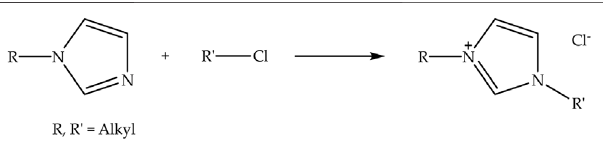
FIGURE 2 | Schematic of the alkylation reaction of N -alkylimidazole with alkyl chloride to prepare N -alkyl- N -alkylimidazolium chloride ionic